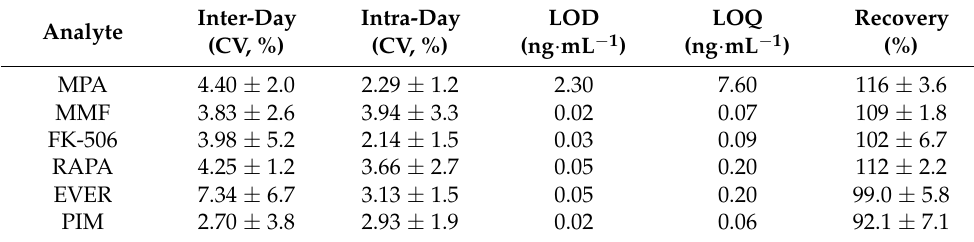
Table 2. Validation